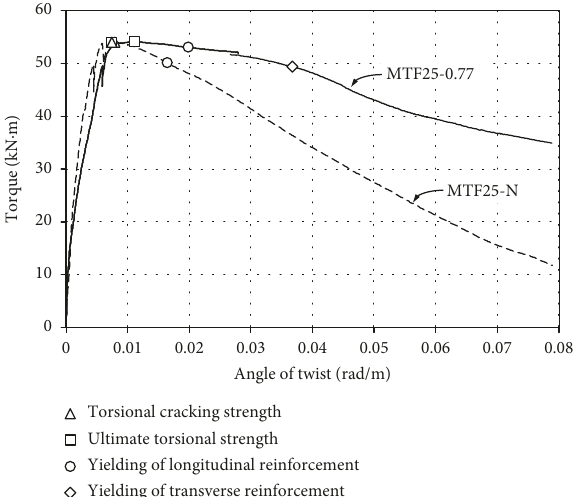
Figure 6: Torsional moment-twist of MTF25 series.